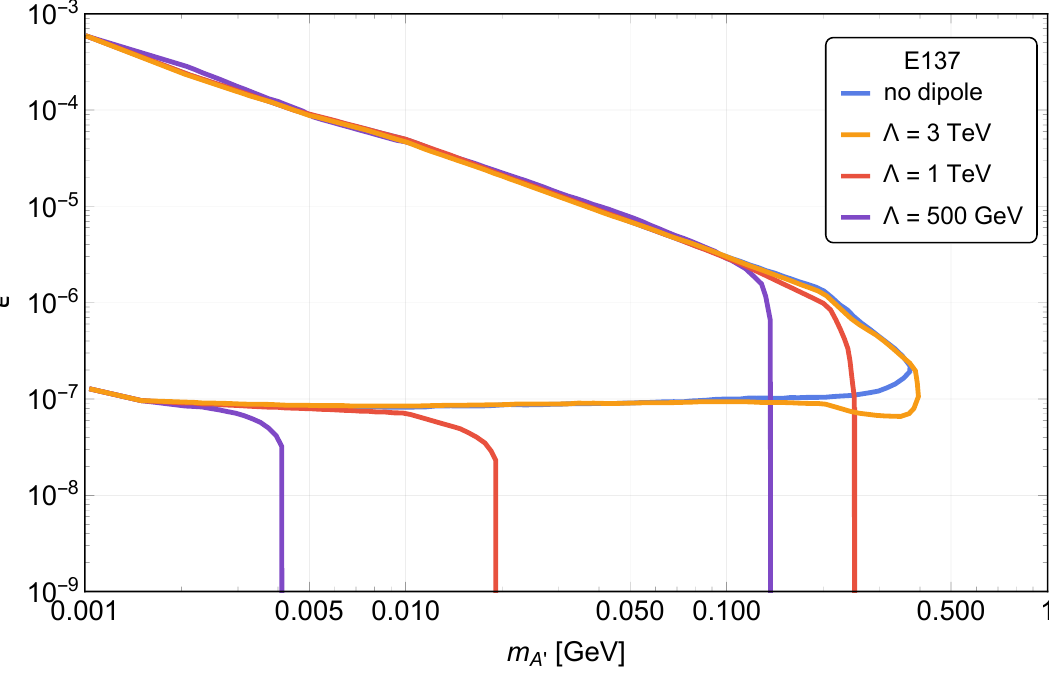
Figure 7 . Exclusion region obtained for E137 assuming the detection of at least 3 dark photon events. The blue curve is the limit obtained in the absence of the dipole operator, while the other curves show the limits for different values of Λ by fixing d